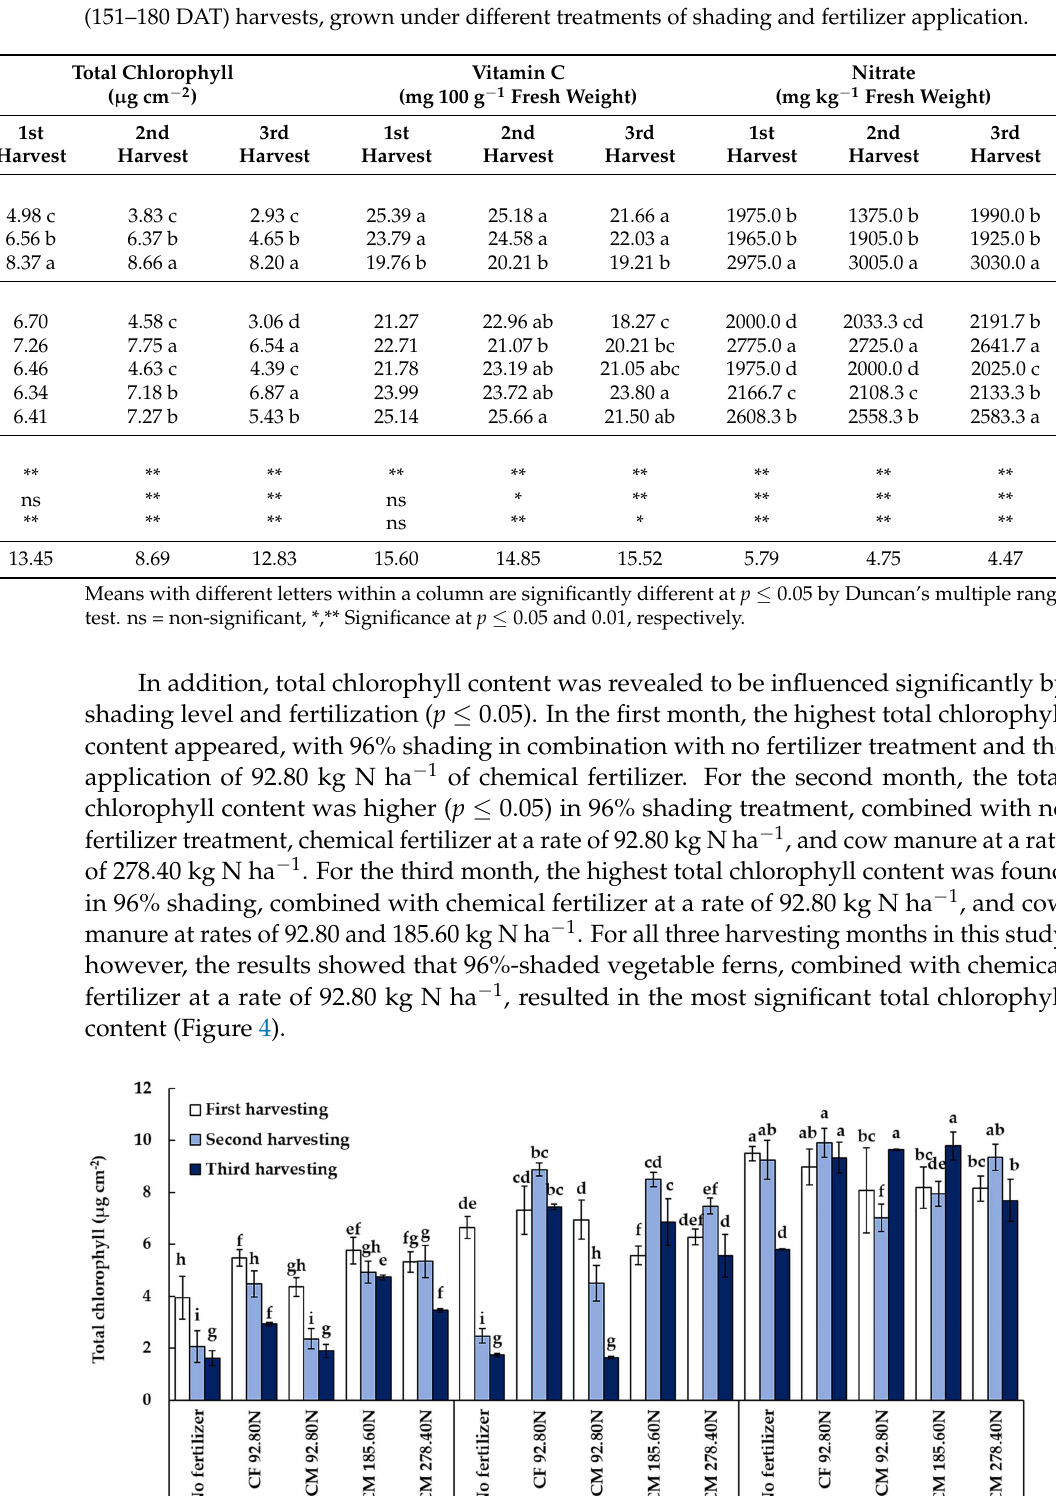
Table 4. Yield quality of vegetable fern at first (90–120 DAT), second (121–150 DAT), and third (151– 180 DAT) harvests, grown under different treatments of shading and fertilizer application.